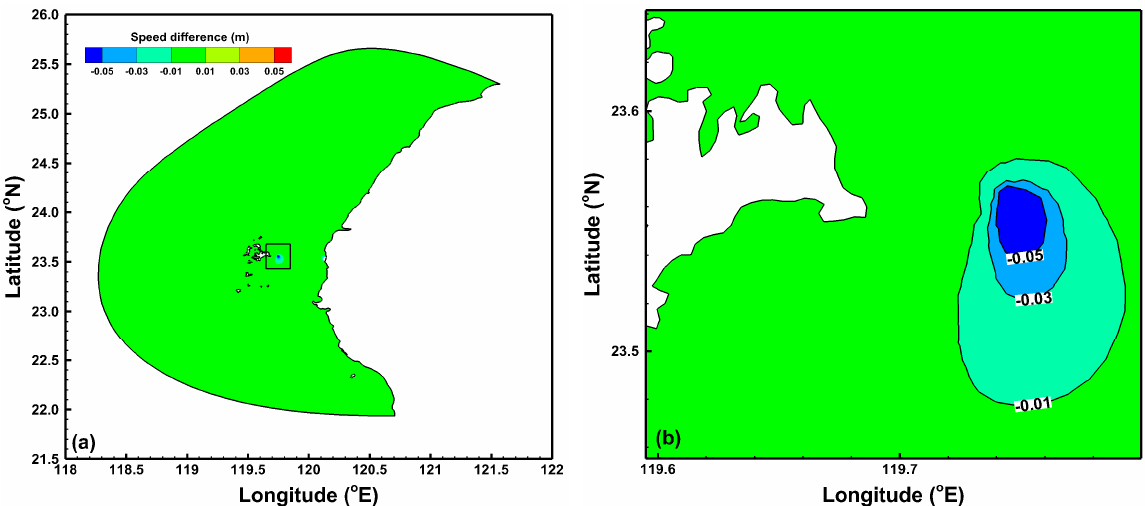
Figure 10. Difference in the mid-flood tidal current for the ( a ) far-field and ( b ) near-field with and without a turbine array.